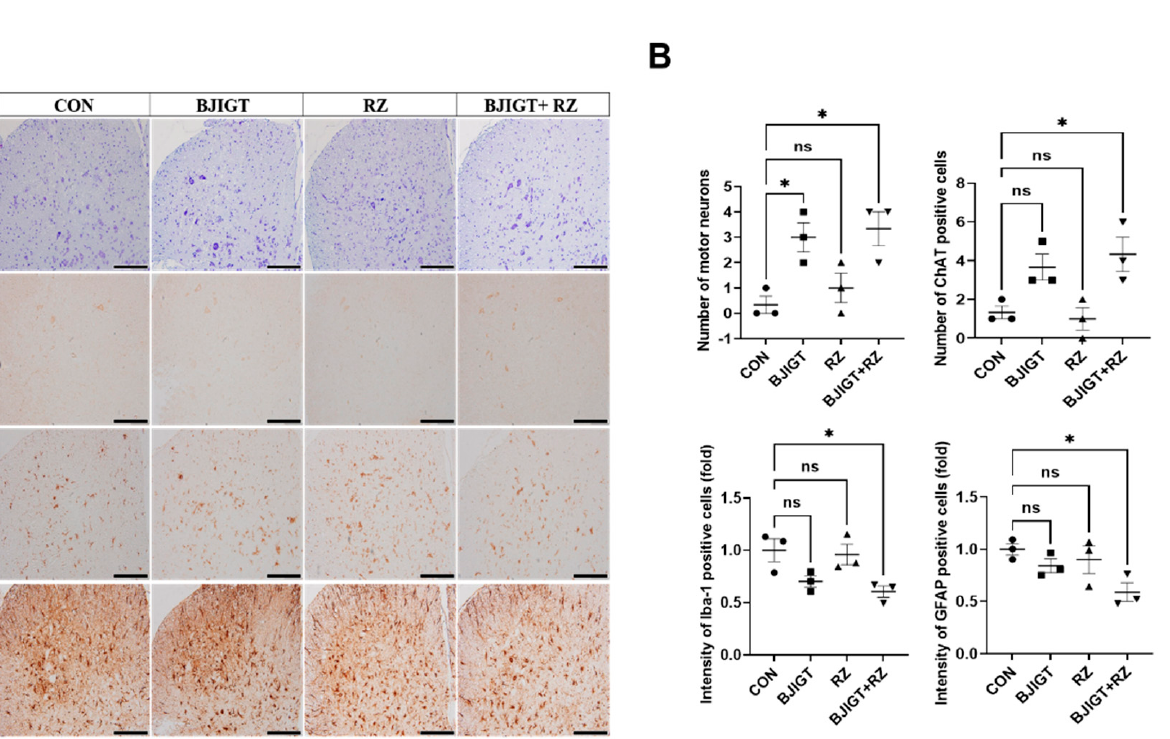
Figure 5. Combined BJIGT/RZ treatment protects motor neurons and reduces neuroinflammation in the spinal cord (SP) of the hSOD1 G93A ALS mouse model. ( A ) Photomicroscopic images of Nissl staining and immunostaining of choline acetyl transferase (ChAT), ionized calcium-binding adaptor molecule 1 (Iba-1), and glial fibrillary acid protein (GFAP) in the SP of each group of hSOD1 G93A ALS mice. ( B ) Quantification of the number of Nissl-stained motor neurons and ChAT- positive neurons (maker for cholinergic neuron), and the intensity of Iba-1 positive cells (marker for microglial cells) and GFAP-positive cells (marker for astrocytes) ( n = 4–5/group) (scale bar, original magnification × 200; bar represents 200 µ m). ( C ) Quantitative analysis of the relative mRNA expression of the proinflammatory cytokines interleukin 1 β ( IL-1 β ), tumor necrosis factor α ( TNF- α ), IL-6 , and interferon γ ( IFN- γ ) in the GC of each group of hSOD1 G93A mice ( n = 4–5/group). ( D ) Representative immunoblots and quantification of the bands pertaining to transforming growth factor β (TGF- β ) in the GC of each group of hSOD1 G93A mice. Tubulin was used as the loading control. Data are normalized to the control group data and presented as mean ± SEM. ns: not significant, * p < 0.05, ** p < 0.01, and *** p < 0.001, compared with the control group. Distilled water (DW)-administered transgenic (Tg) mice (CON), BJIGT-treated Tg mice (BJIGT), RZ-treated Tg mice (RZ), and combined BJIGT/ RZ-treated Tg mice (BJIGT+RZ). The different number of circles, squares and triangles are indicated the number of sample sot.